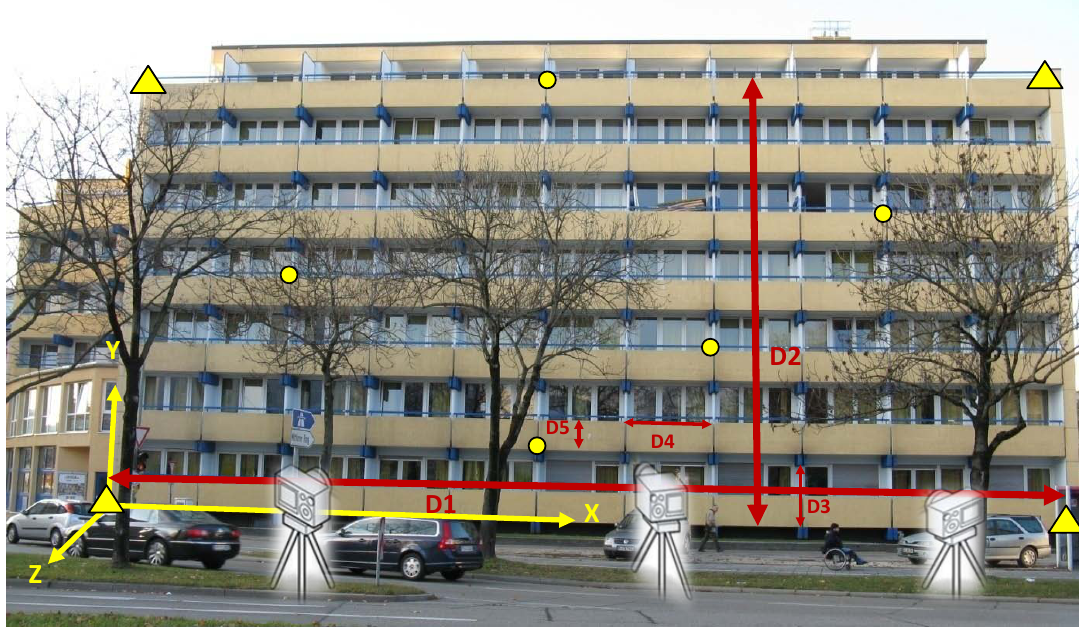
Figure 1: overview image of the facade with coordinate system, measured distances, control points (triangles: full CP, circles: height CP) and camera directions (schematically). Additional measurements: total length of facade (D1), total height of facade (D2), distance between two balcony carriers (D3), width of balcony parapet wall (D4) and height of balcony parapet wall (D5).